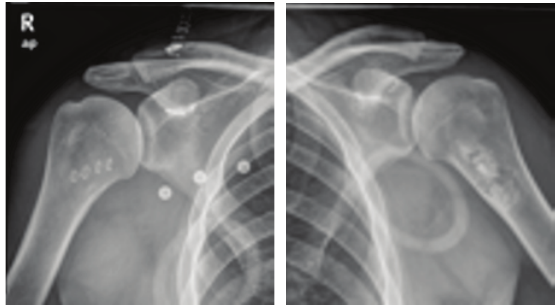
Figure 1. a.p. X - ray right (R) and left (L) on admission showing typical “bulp sign”